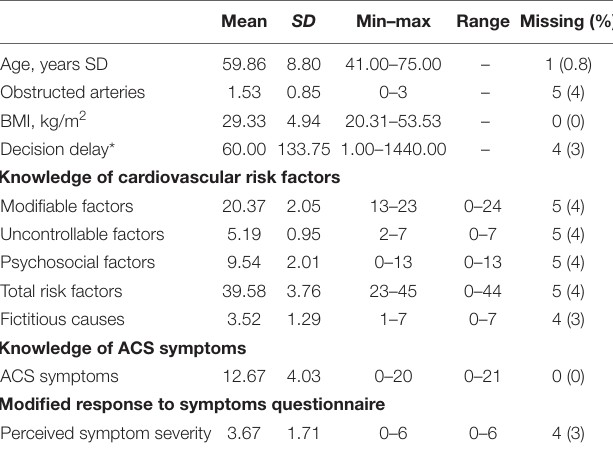
TABLE 2 | Descriptive statistics for the sample (continuous